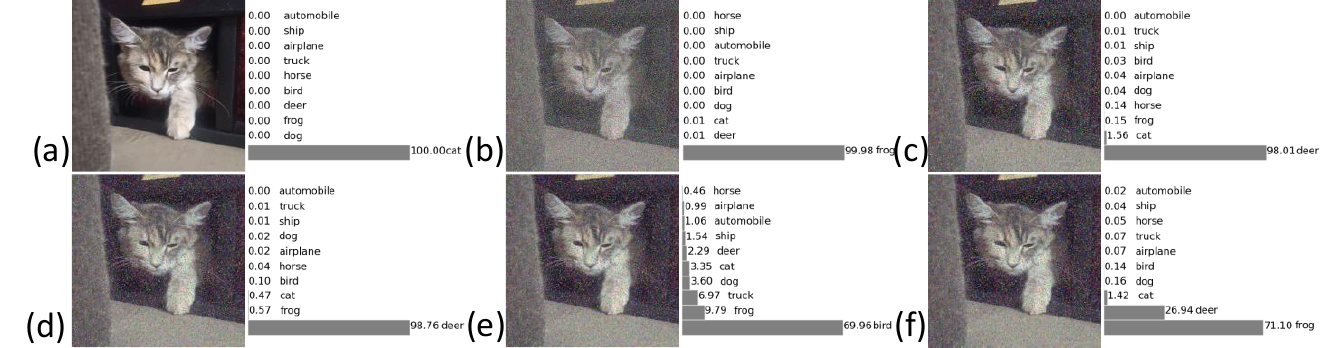
Figure 8. Results of image “ Cat_ Maine_Coon ” recognition: ( a ) original image; ( b ) image noisy with random-valued impulse noise of intensity 50%; ( c ) image cleaned by the method [28]; ( d ) image cleaned by the method [25]; ( e ) image cleaned by the method [27]; ( f ) image cleaned by the proposed method.